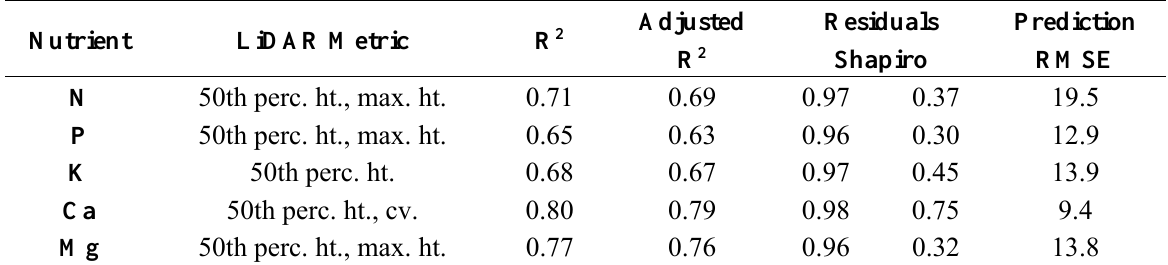
Table 2. Predictive models generated from LiDAR structural metrics using multiple linear regression. RMSEs are reported as percent of the